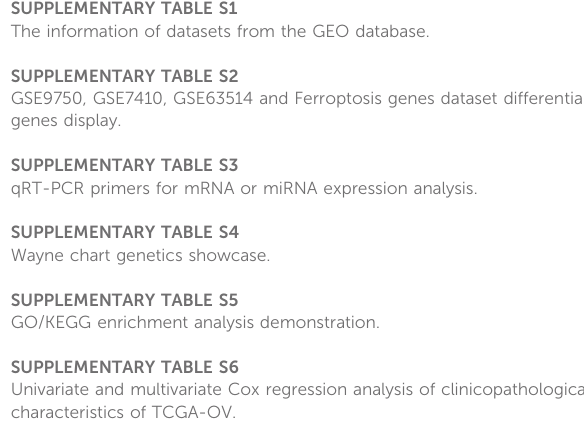
SUPPLEMENTARY FIGURE S2 Lasso Cox analysis (A: Lasso coef fi cient B: Lasso variable track). SUPPLEMENTARY FIGURE S3 Validation of FRGs in cervical cancer in TCGA-OV (A: Curve scatter plot of training set survival model ef fi cacy assessment and cumulative scatter plot ofsurvivalmortality event risk.B:KMcurves show asigni fi cant difference in OS between high-risk and low-risk groups in TCGA-OV. C: Time-dependent ROC curves were used to predict 1, 3, and 5 years survival. D: 1, 3, and 5 years nomograms for predicting OS in cervical cancer. E: Calibration curves showing the agreement between predicted and observed 3 and 5 yearsOS.F:Decisioncurveanalysisoftheprognosticmodelinthetraining set at 3 and 5 years.). SUPPLEMENTARY FIGURE S4 GSE44001 immune in fi ltration analysis (A: Differences of 24 immune cells in differentexpressionlevels ofRisk score. B:Correlation between24 immune cells.). SUPPLEMENTARY FIGURE S5 Six genes were analyzed in TCGA database (A: the expression of JUN B:the expression of TSC22D3 C: the expression of SLC11A2 D: the expression of DDIT4 E: the expression of DUOX1 F: the expression of HELLS). SUPPLEMENTARY FIGURE S6 Analysis of immune in fi ltration of 4 genes (A: Correlation between JUN and immune cells B: Correlation between TSC22D3 and immune cells C: Correlation between DUOX1 and immune cells D: Correlation between HELLS and immune cells). SUPPLEMENTARY TABLE S1 The information of datasets from the GEO database.